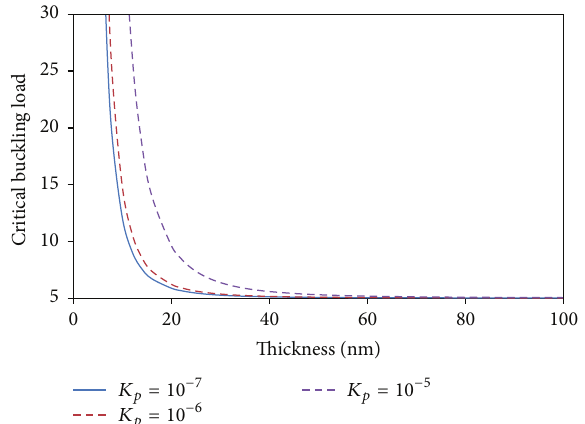
Figure 11: Dimensionless critical buckling load with respect to thickness ℎ for various Pasternak elastic foundations (𝐾 𝑤 = 10 10 , 𝑅 = 30 nm , Δ𝑇 = 100, 𝜇 = 1, 𝑏 = 50 nm , 𝜃 = 𝜋/2)